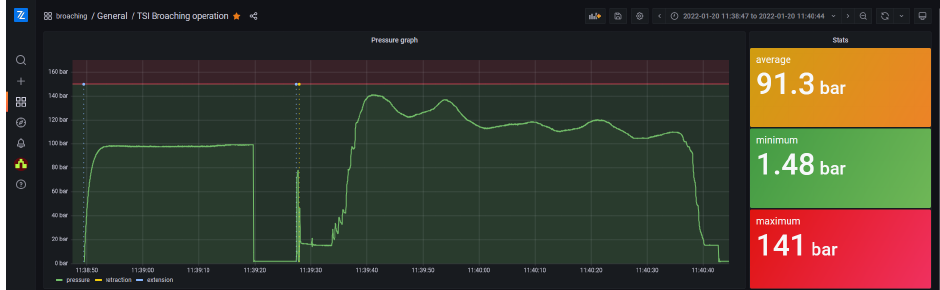
Figure 7. Characteristic pressure progression during one single cut shown in the Zerynth